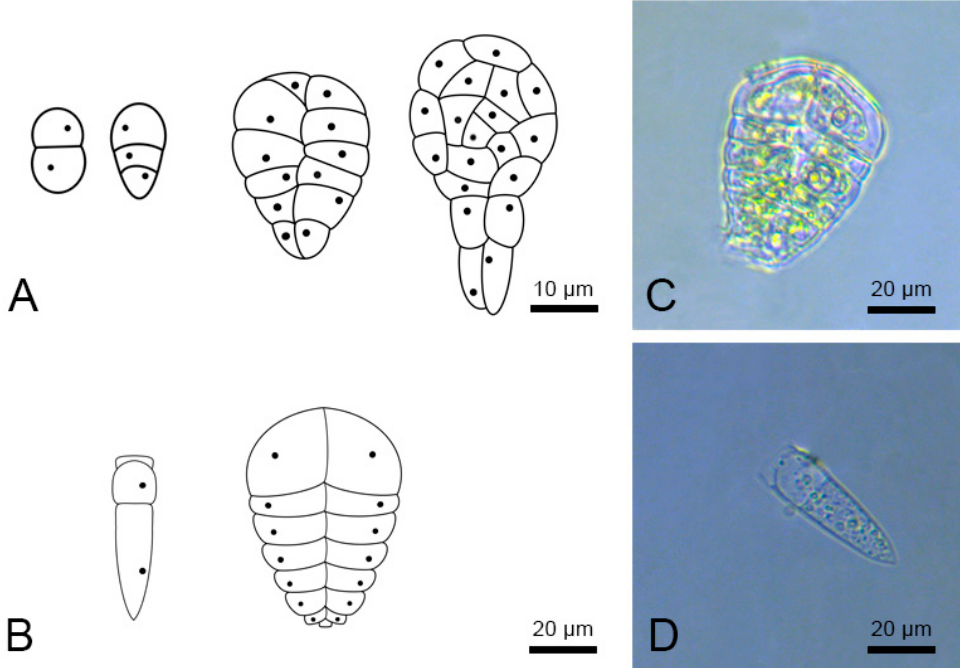
Figure 3. Similarity of gametic embryos and sunflower trichomes in vitro: ( A ) schematic of the developmental stages of a microspore-derived embryo; ( B ) schematic of the sunflower trichome morphology; ( C , D ) different morphologies of sunflower trichomes in a liquid medium. Photographs were taken by authors of this review.